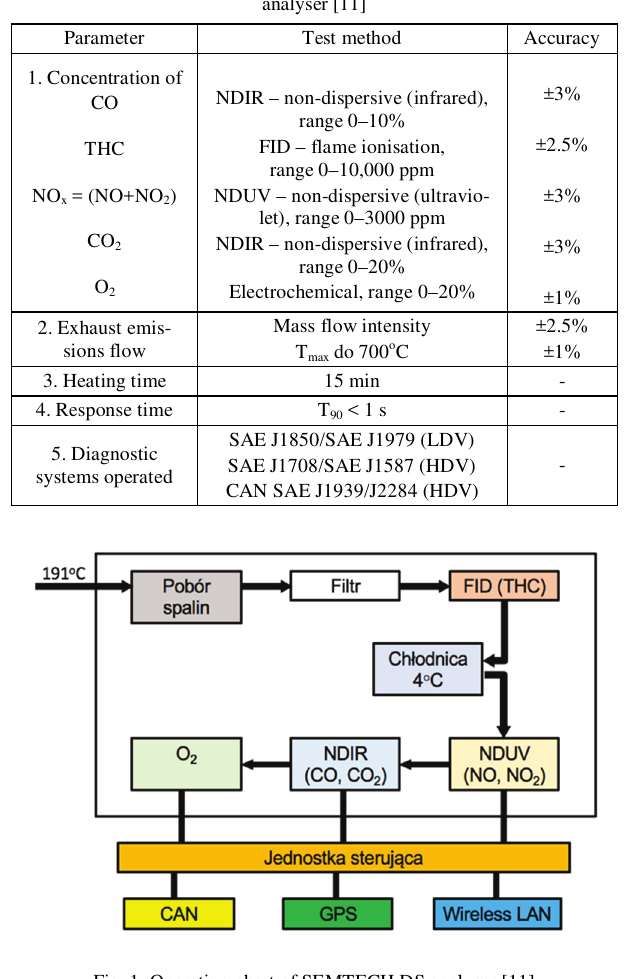
Fig. 1. Operating chart of SEMTECH DS analyser [11]